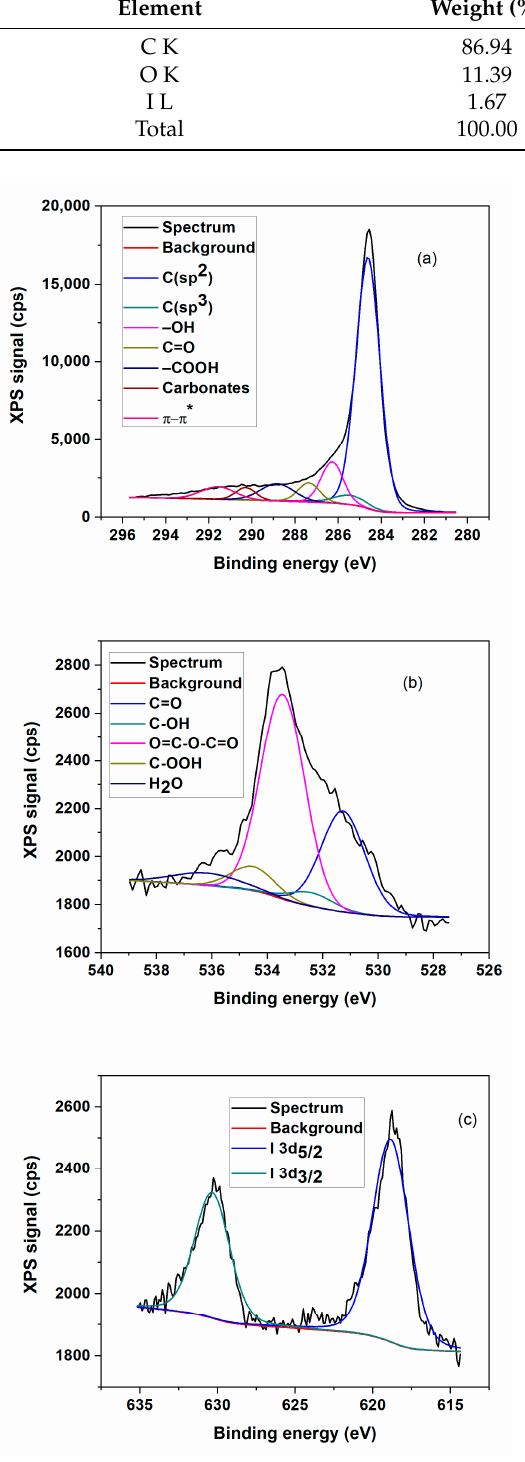
Figure 2. Detailed XPS high resolution survey for I/rGO sample: ( a ) carbon C1s; ( b ) oxygen O1s; and ( c ) iodine I3d. Table 2. Chemical composition for prepared iodine-doped graphene.